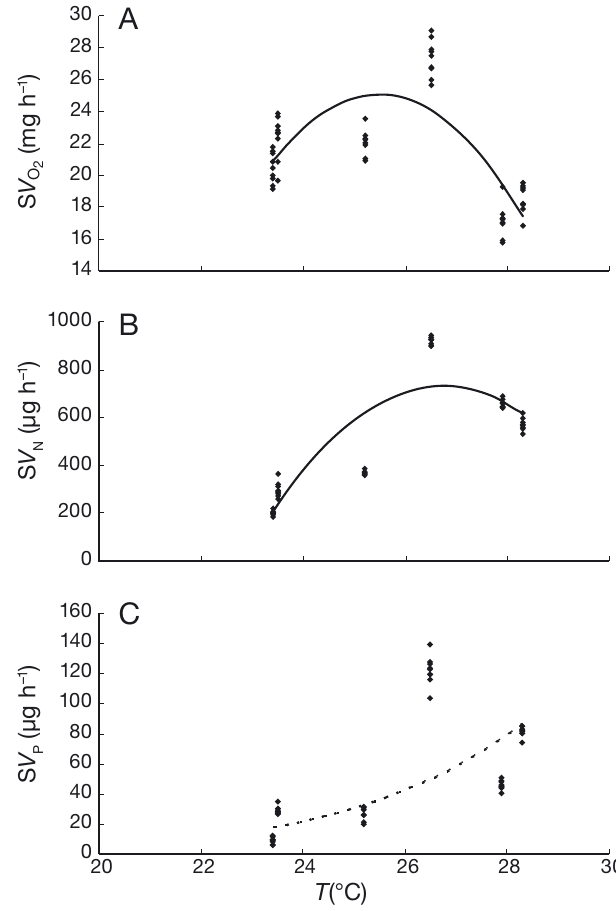
Fig. 4. (A) Standardized oxygen consumption rate (S V O2 ) ver- sus water temperature ( T) . (B) Standardized nitrogen excretion